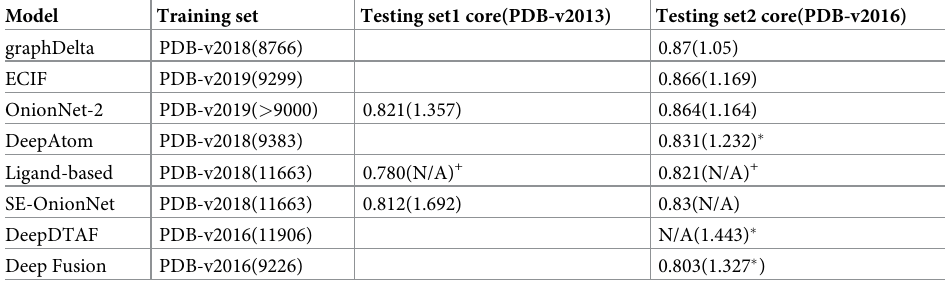
Table 5. The performance in terms of PCCs and RMSEs ( pK d / pK i ) for recently-proposed models using different training sets [54–64]. Note that values marked with � uses PDBbind-v2016 core set ( N = 290), and the values